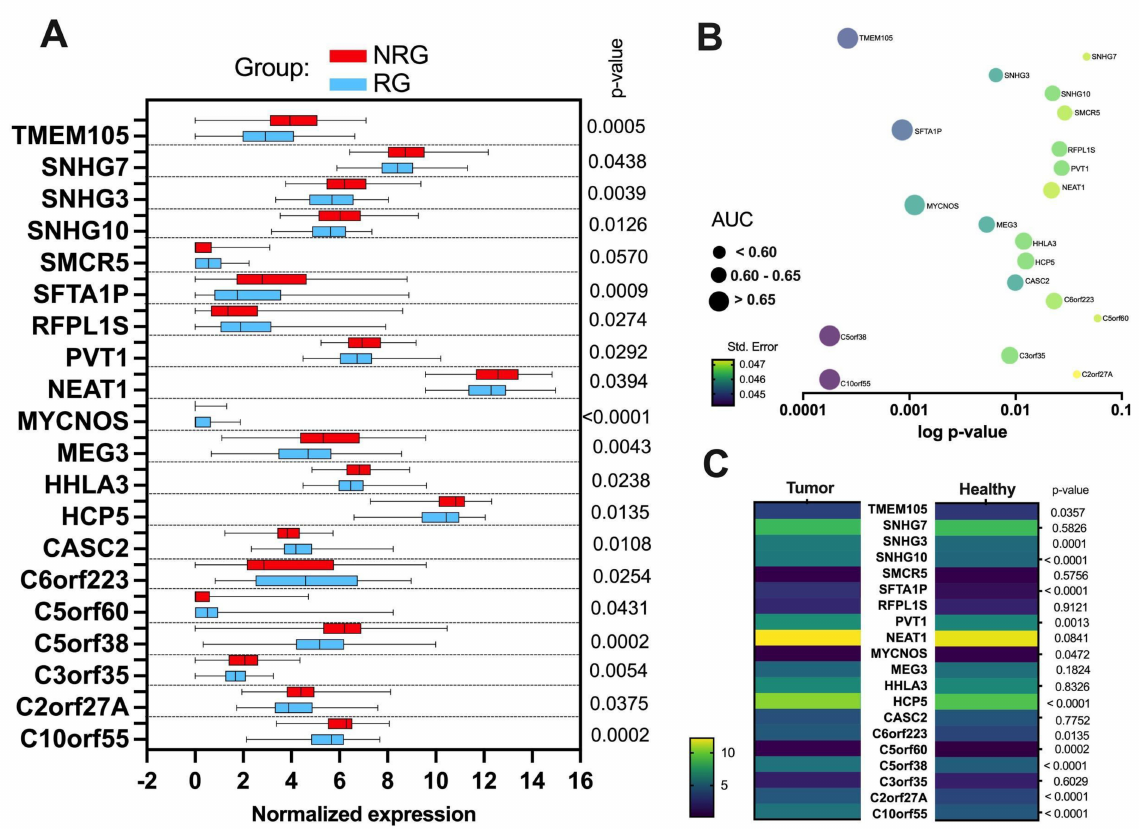
Figure 3. lncRNA expression profile ( A ) in responders’ group (RG) and non-responders’ group (NRG) of patients to radiotherapy and ( B ) assessment of the parameter AUC (Area under the ROC Curve) to discriminate the RG and NRG groups. ( C ) Comparison of expression levels of twenty lncRNAs between tumor ( n = 522) and healthy ( n = 44) using all HNSCC data taken from the TCGA; Student t -test or Mann-Whitney U test, p < 0.05 considered statistically